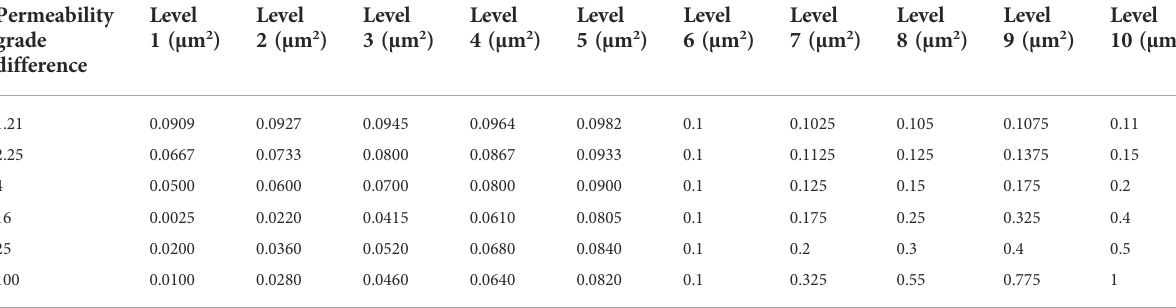
TABLE 4 Distribution of oil reservoir permeability at different permeability ratios.